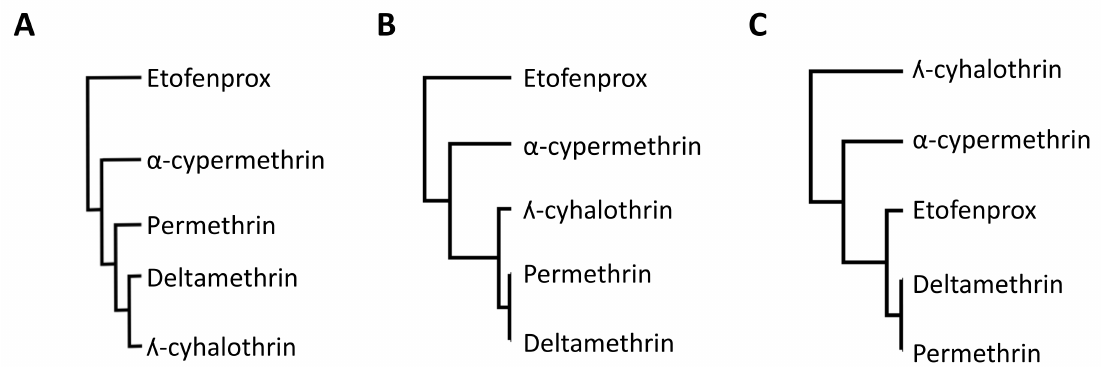
Figure 3. Hierarchical relationships among pyrethroids defined using data on resistance in vectors and functional activity data. The dendrograms were constructed using correlations in mortality across African malaria vector populations (Pearson’s correlation coefficient) ( A ), binding affinity values (IC50), ( B ) and insecticide depletion values (%) ( C ). Adapted from